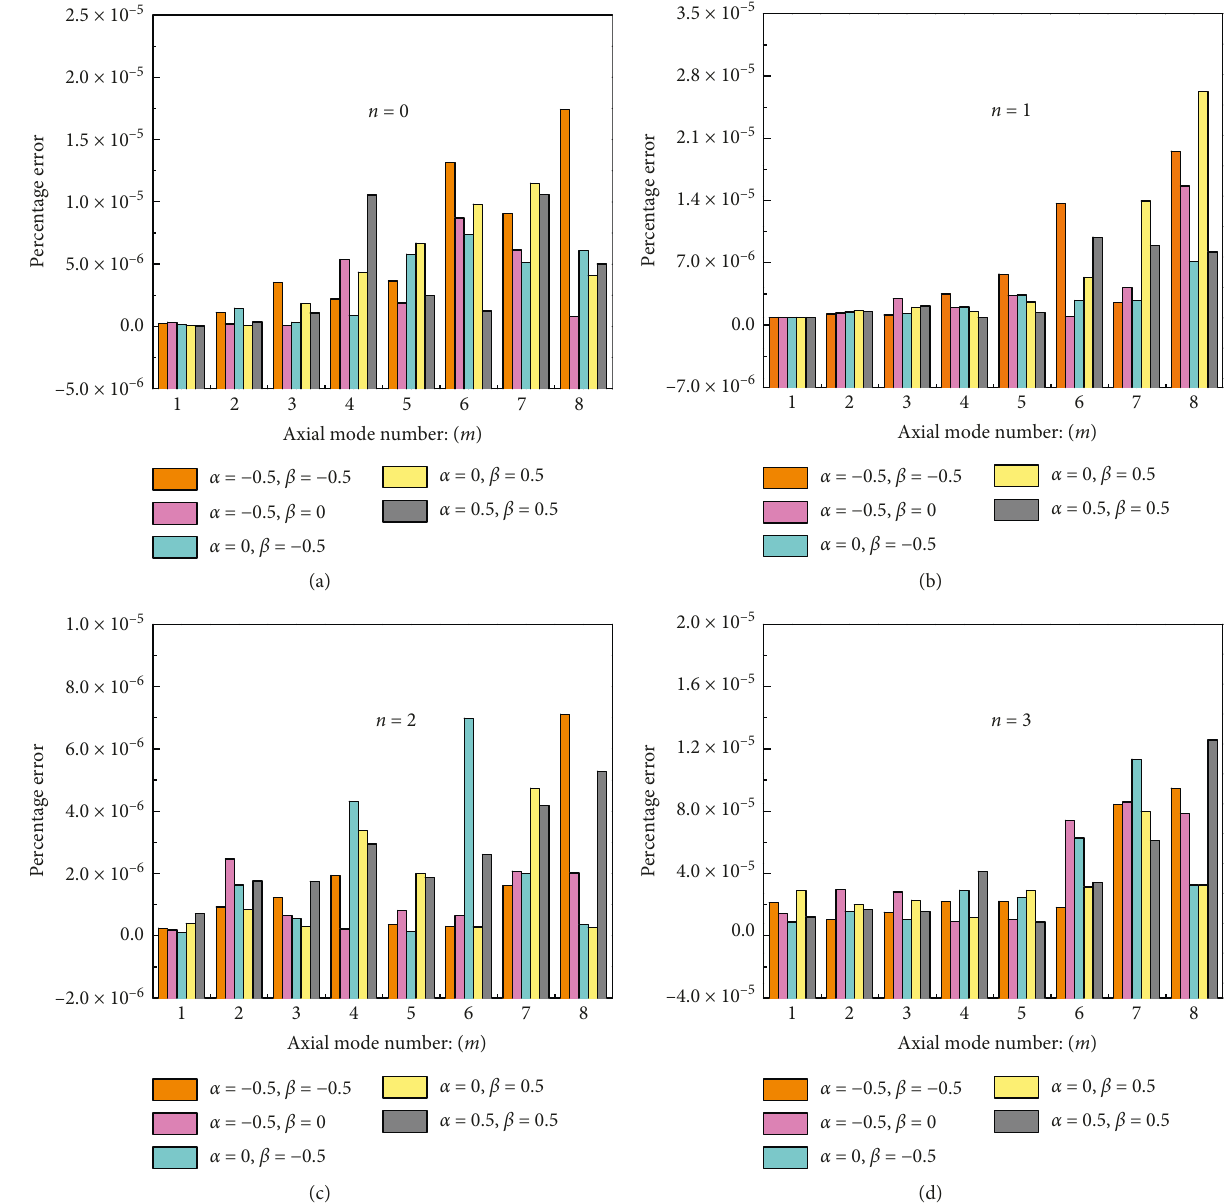
Figure 5: Fractional error of frequency parameters Ω of uniform spherical cap with different Jacobi parameters (BC: